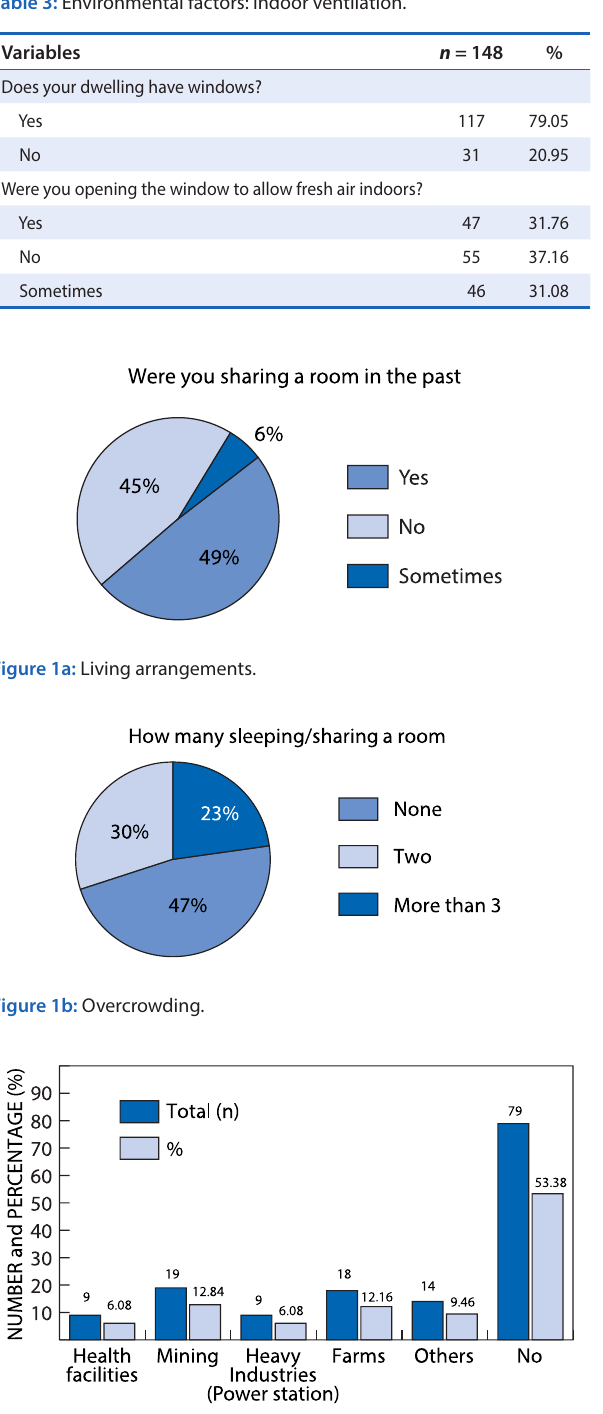
Figure 1c: Work environment.